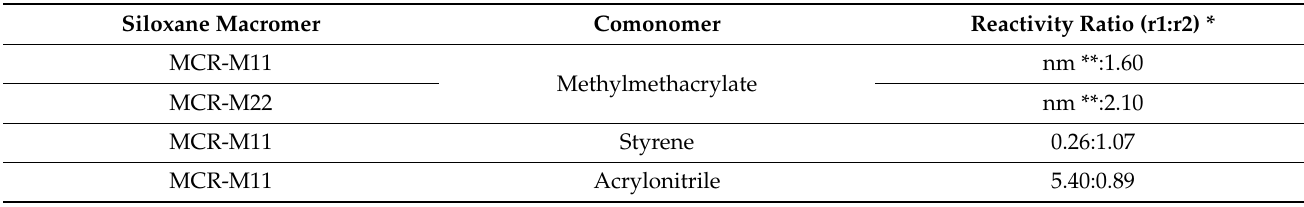
Table 5. Reactivity Ratios of Methacrylate Functional Siloxane Macromers.